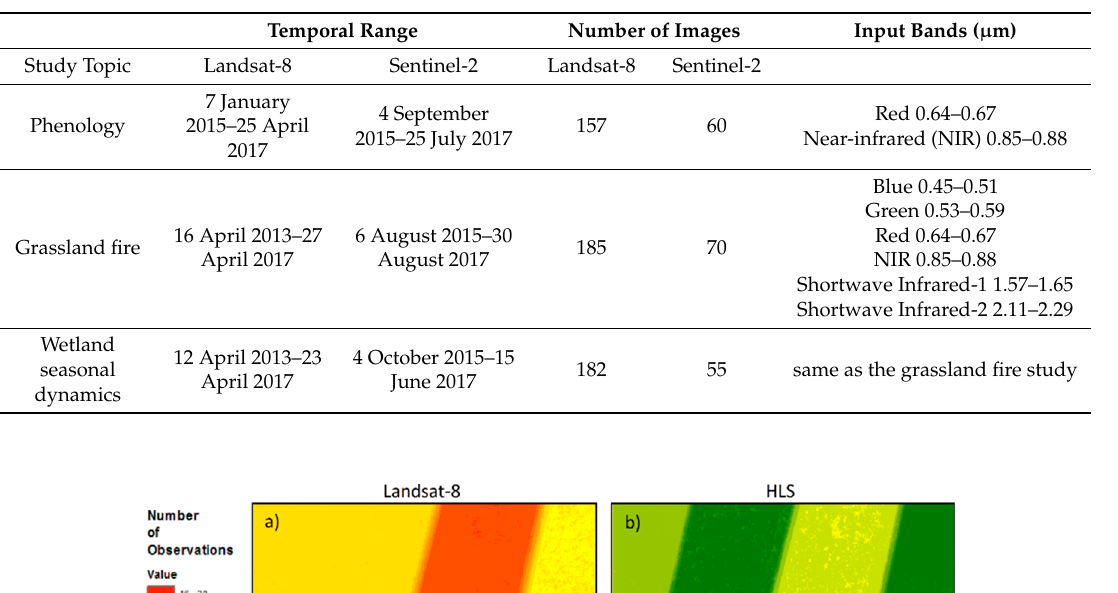
Table 1. The temporal range, number of images, and extracted spectral bands (based on Landsat-8) for each study area.